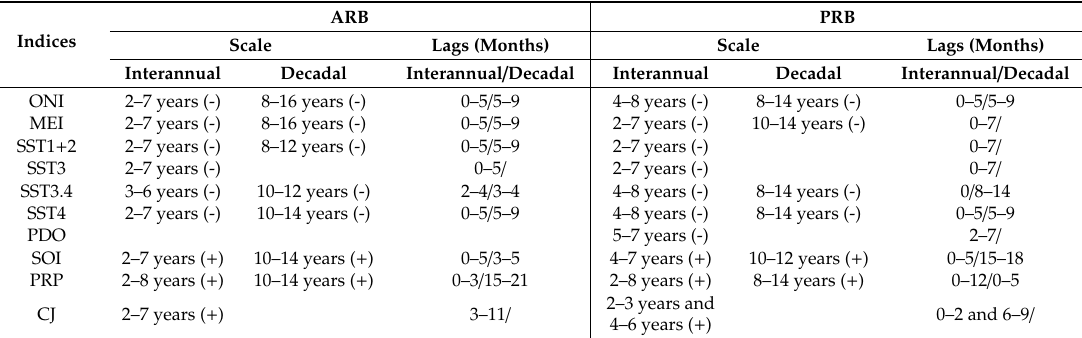
Table 5. Main results obtained by wavelet transform